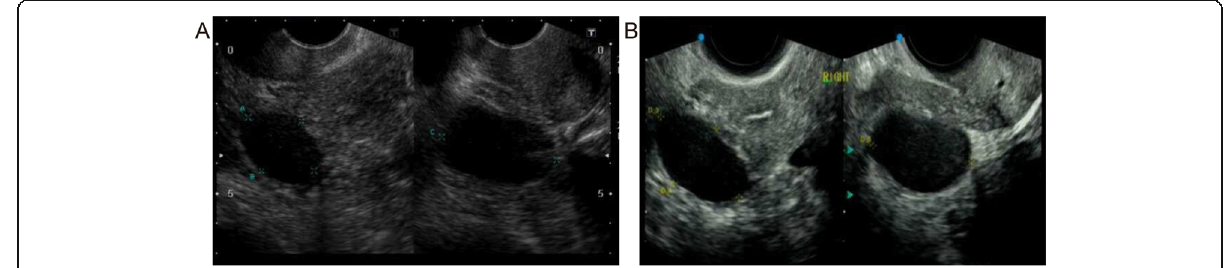
Fig. 1 The sonographic findings of the uterine EOBTs. A hypoechoic mass measured 5.2 x 5 x 4.7 cm was detected incidentally 2 years ago ( a ). The lesion was indolent, approximately 5.8 cm in greatest diameter ( b )